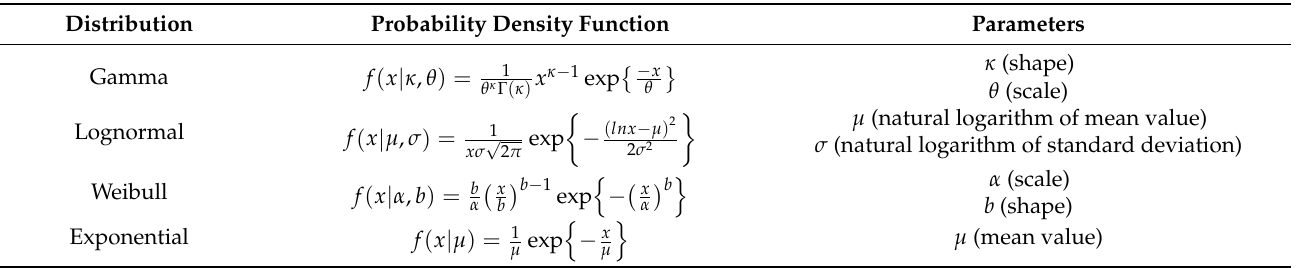
Table 1. Definitions of the probability density functions (pdf) of the Gamma, Lognormal, Weibull and Exponential distributions applied in the statistically independent interevent times data, ∆ T , of the 10 sub-areas of broader Aegean